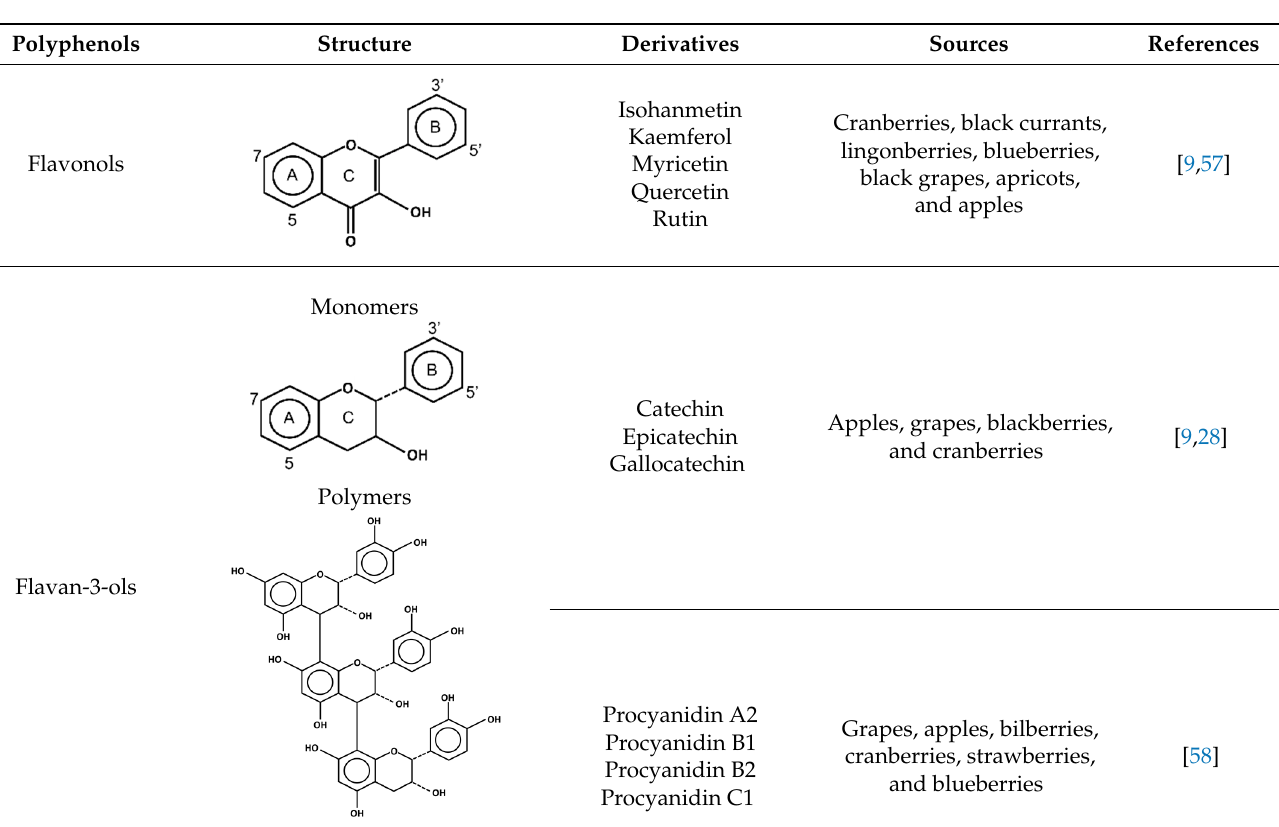
Table 2. Polyphenols and their derivatives in fruit.